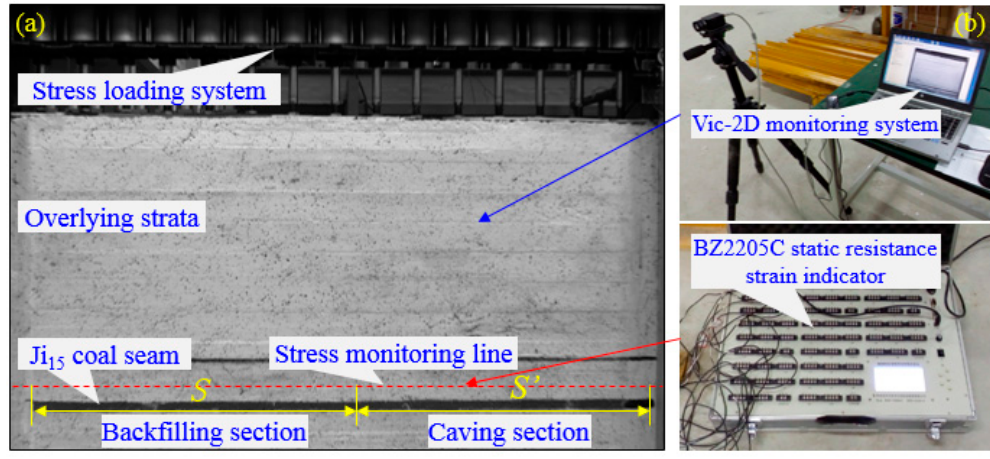
Figure 3. The testing model and monitoring system: ( a ) physical model; ( b ) monitoring system.